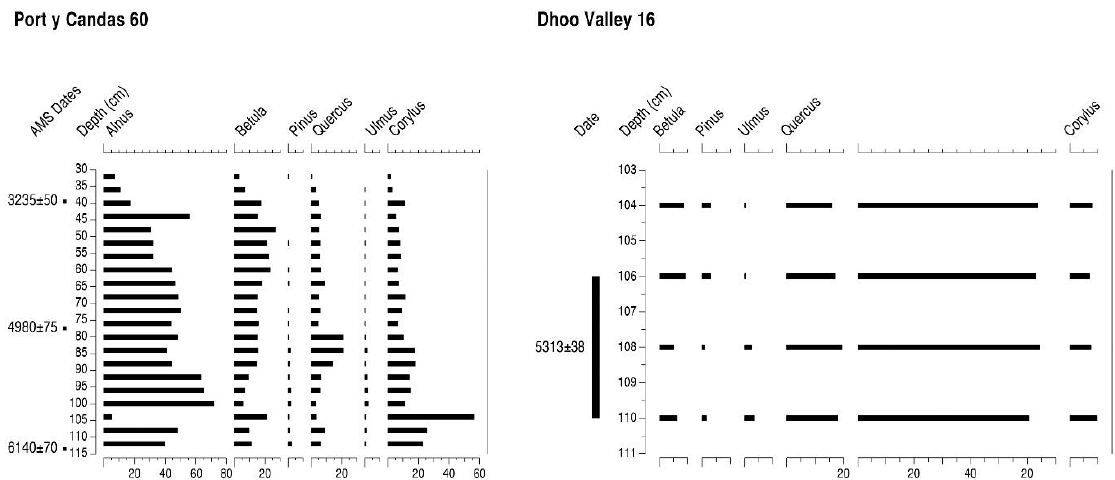
Figure 9. Percentage pollen diagrams from Port y Candas 60 and Dhoo Valley 16, Isle of Man, showing selected tree taxa and 14 C BP AMS ages.